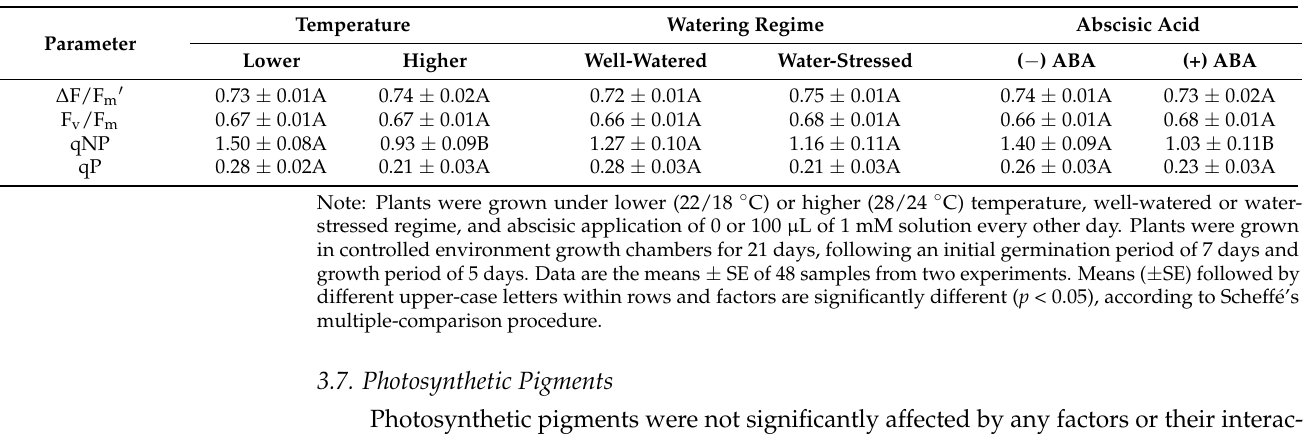
Table 12. Effects of temperature, watering regime, and abscisic acid on chlorophyll fluorescence of tomato plants.